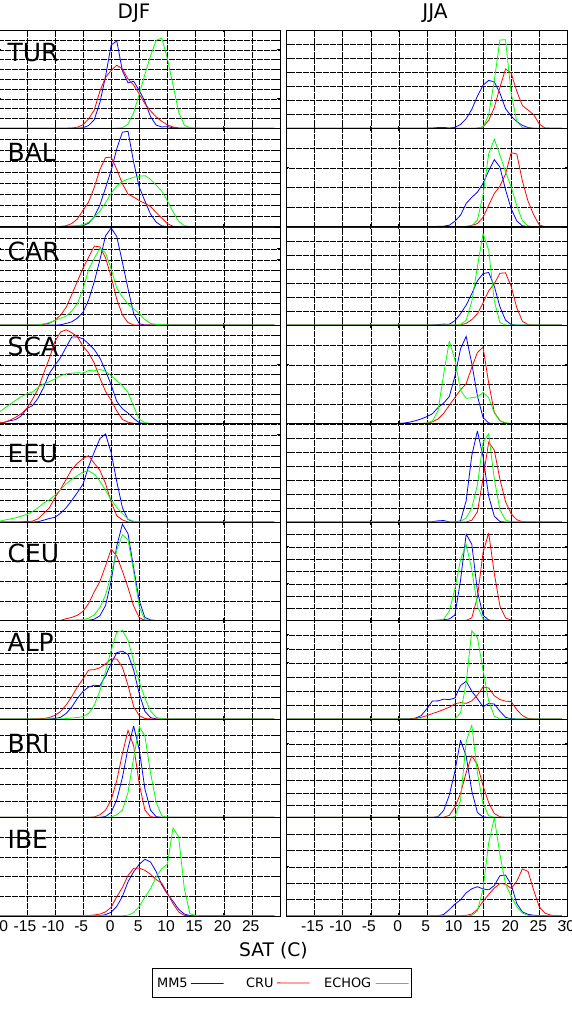
Fig. 11. PDFs of seasonal series of precipitation in the nine sub- areas of Europe shown in Fig. 2. The results for winter (left pan- els) and summer (right panels) are presented for MM5, CRU and ECHO-G. The horizontal axis shows the units of precipitation in mmmonth − 1 , while the vertical indicates relative frequency in ar- bitrary